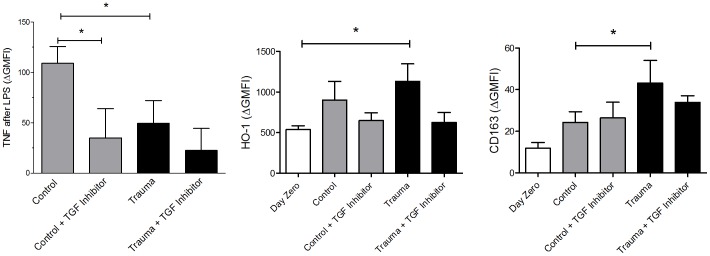
Intracellular HO-1 levels and surface CD163 expression were not affected by TGF-β receptor inhibition with SB431542 (TGF Inhibitor) on CD14+ monocytes incubated with control or trauma patient plasma for 22 hours.TNF-α response to LPS stimulation (10 ng/ml) was significantly diminished with SB431542. *, P<0.05; nonparametric Wilcoxon test was used to determine statistical significance; n = 6 for each separate experiment.